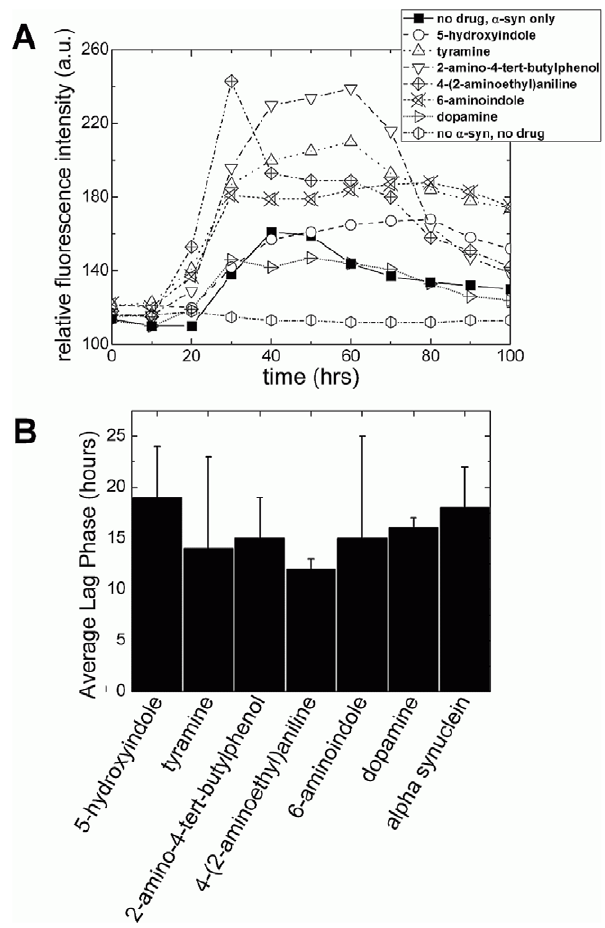
Figure 3. The kinetics of a -syn fibrillization with the DOP analogs in comparison to a -syn alone. (A) Kinetics curves of a -syn fibrillization in the presence of the test ligands. The fibrillization buffer (i.e, no protein) was assayed in the absence of both a -syn and the test ligands. All curves represent the mean kinetics output from at least 3 measurements. (B) Bar chart statistics displays no significant difference between the lag phases.